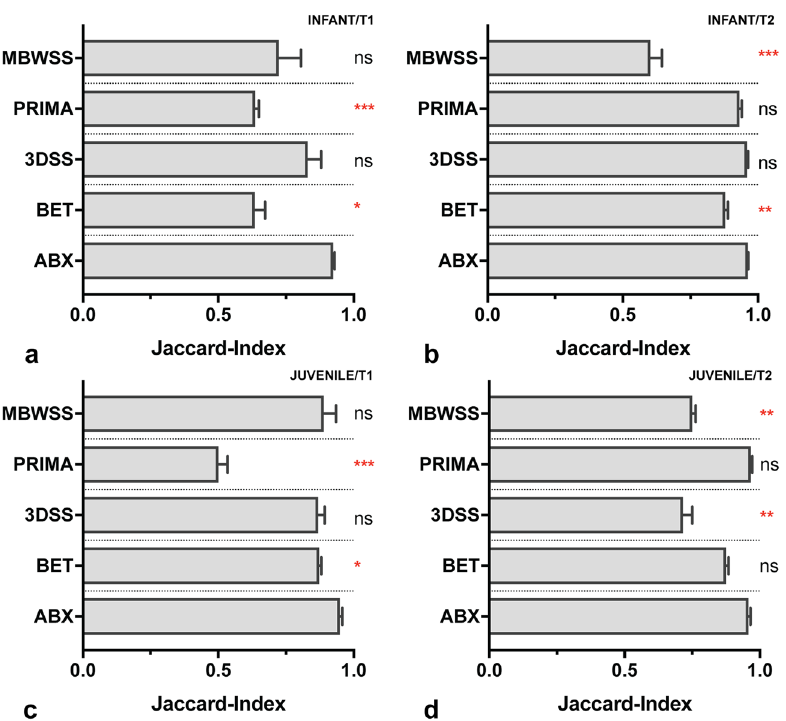
Figure 3. Evaluation with infant and juvenile rhesus macaques. Bar graph diagrams ( a – d ) demonstrating results from atlasBREX (ABX), Brain-Extraction-Tool v2 (BET), 3dSkullStrip (3DSS), Primatologist-Toolbox (PRIMA) and Marker based watershed scalper (MBWSS) for each dataset (4 groups, each n = 8). Results from alternate technical methods were compared to ABX using Friedman test followed by Dunn’s post-hoc test. ( * ) p-value < 0.05, ( ** ) p-value < 0.01, ( *** ) p-value < 0.001, (ns) non-significant. Mdn,